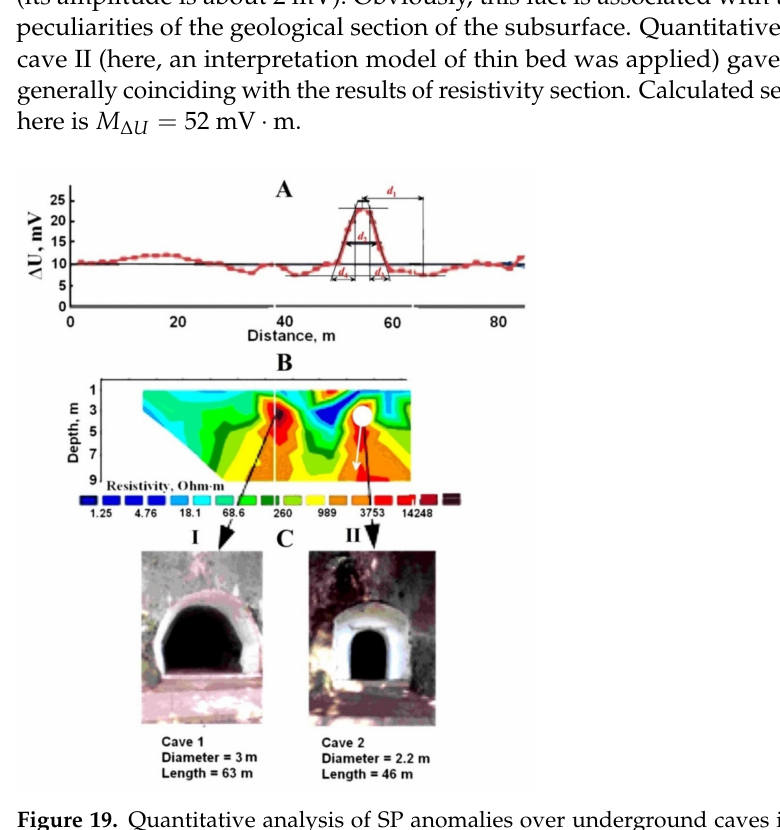
Figure 19. Quantitative analysis of SP anomalies over underground caves in the Djuanda Forest Park, Bandung (Indonesia). ( A ) SP profile with interpretation of anomaly II, ( B ) ERT section, ( C ) geological section. Initial data taken from [28]. The white circle and arrow indicate the position of upper edge of cave II and its dipping (distribution of the highest resistivities). Black arrows show corresponding